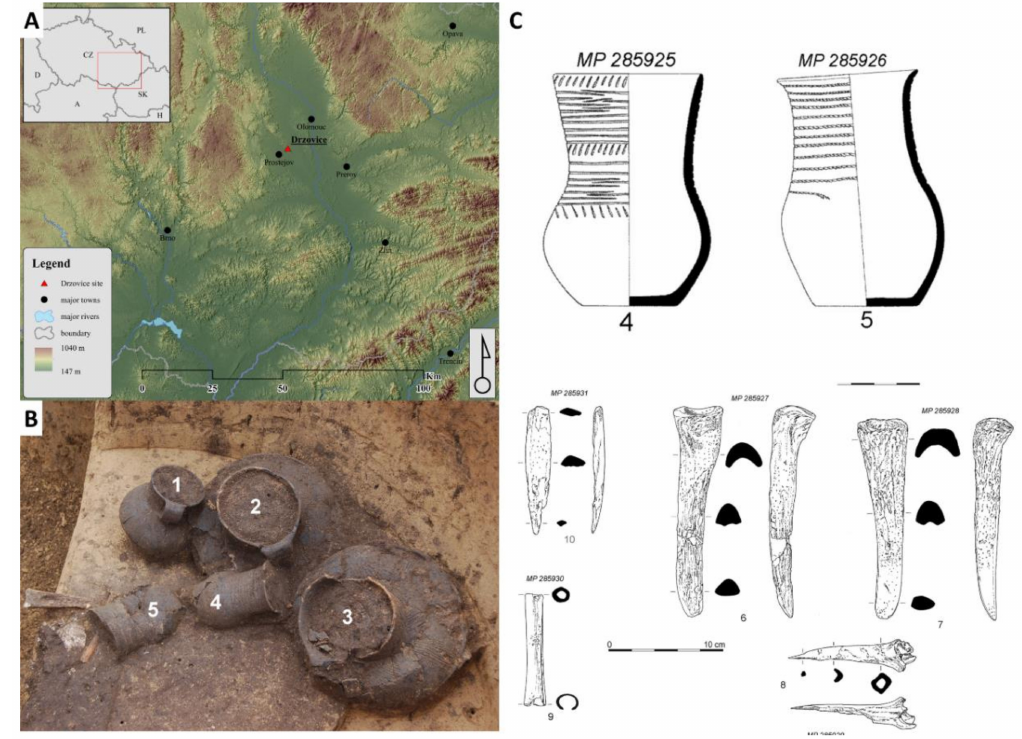
Figure 3. Place of rescue excavation ( A ), five ceramic vessels in the grave ( B ), and drawing of ceramic potteries and bone tools ( C